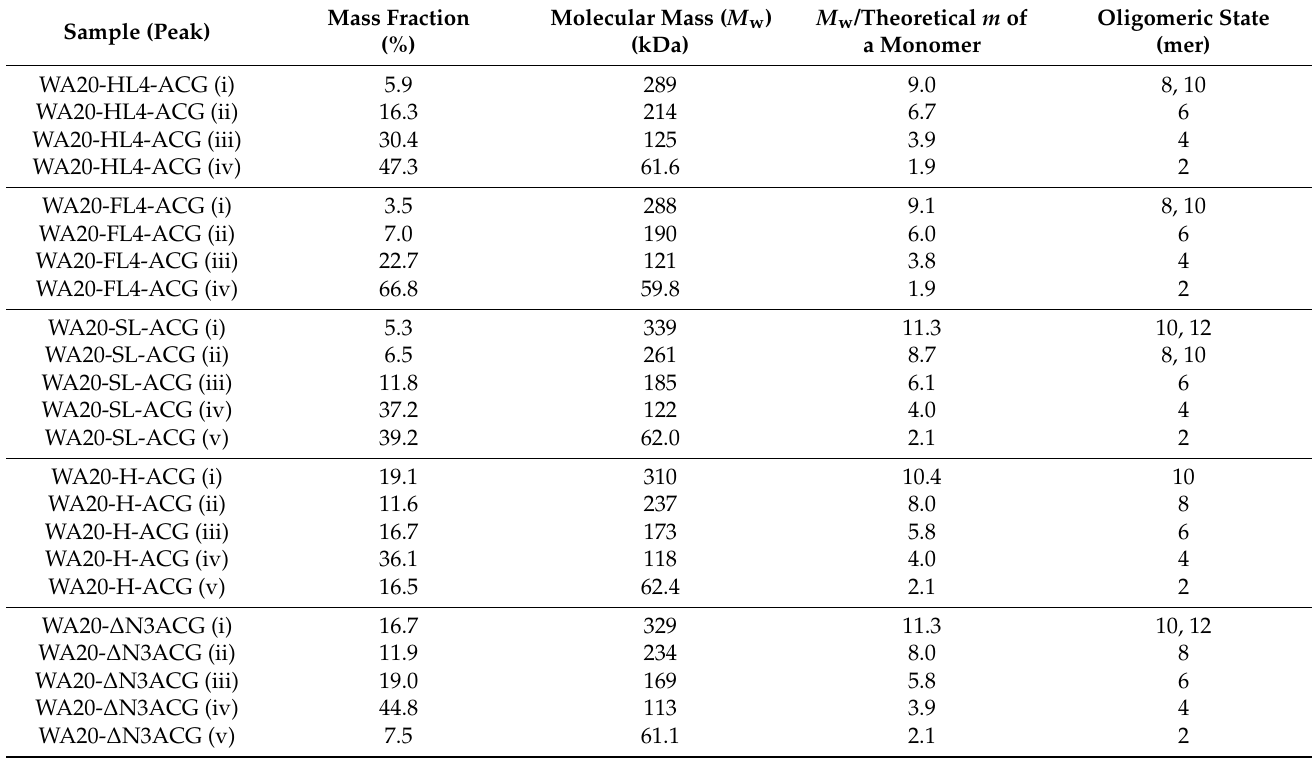
Table 1. Summary of the SEC–MALS